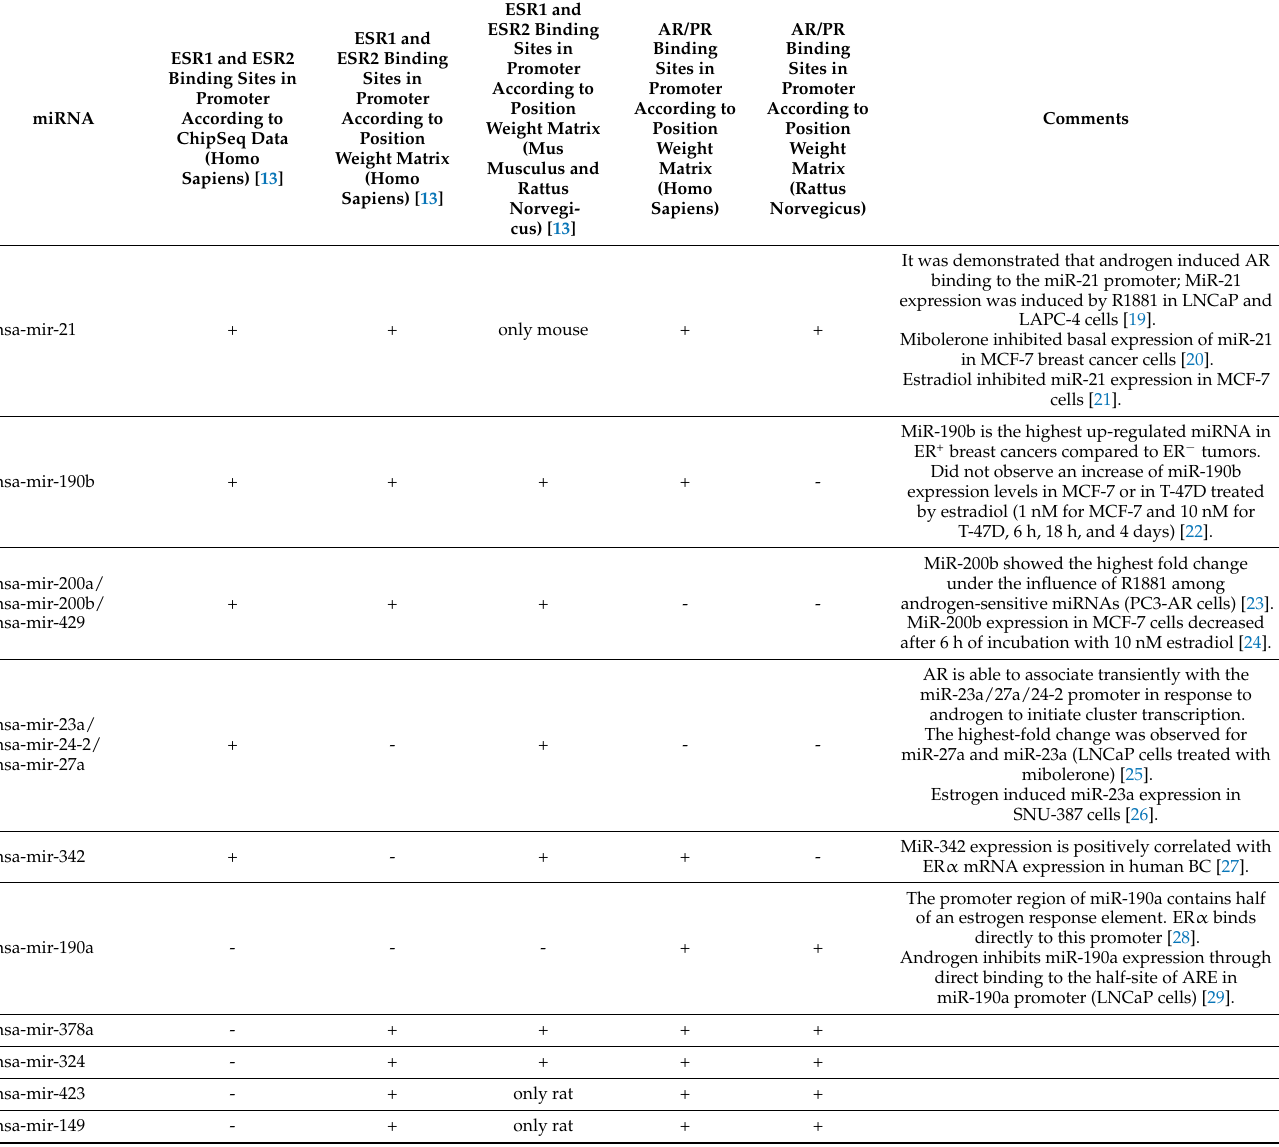
Table 2. The miRNAs potentially regulated by ER, PR, and